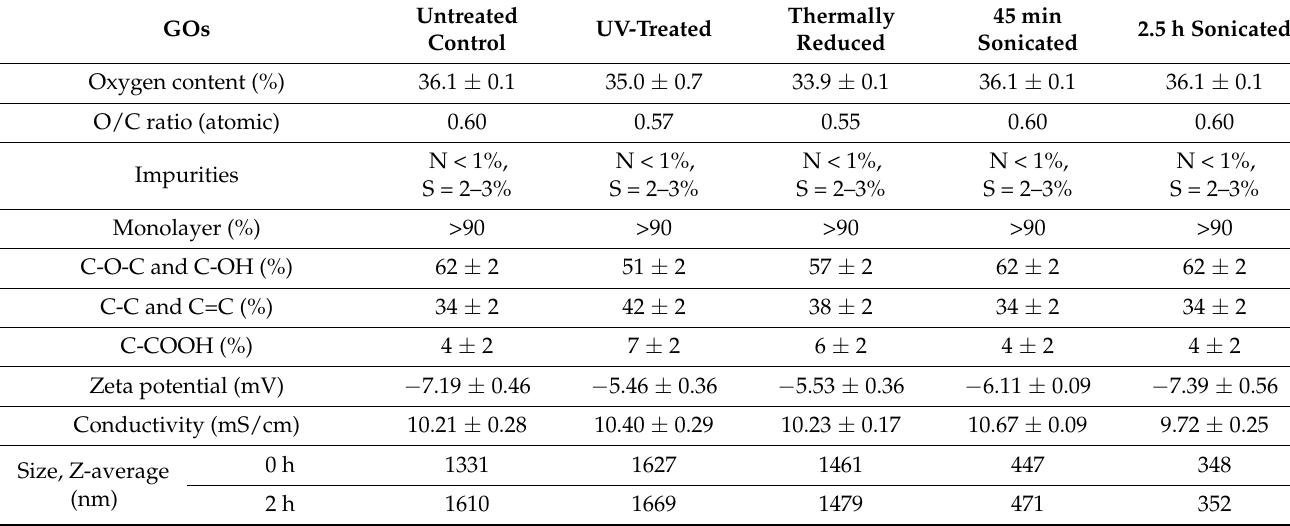
Table 1. Characterization of graphene oxides. Changes in zeta potential, conductivity, and aggregation size were measured in synthetic defined (SD) medium during a 2 h